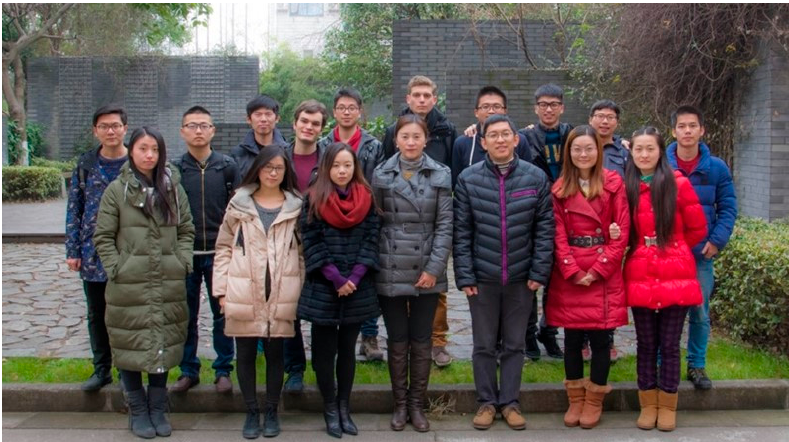
Figure 3. Professor Shen’s research group.